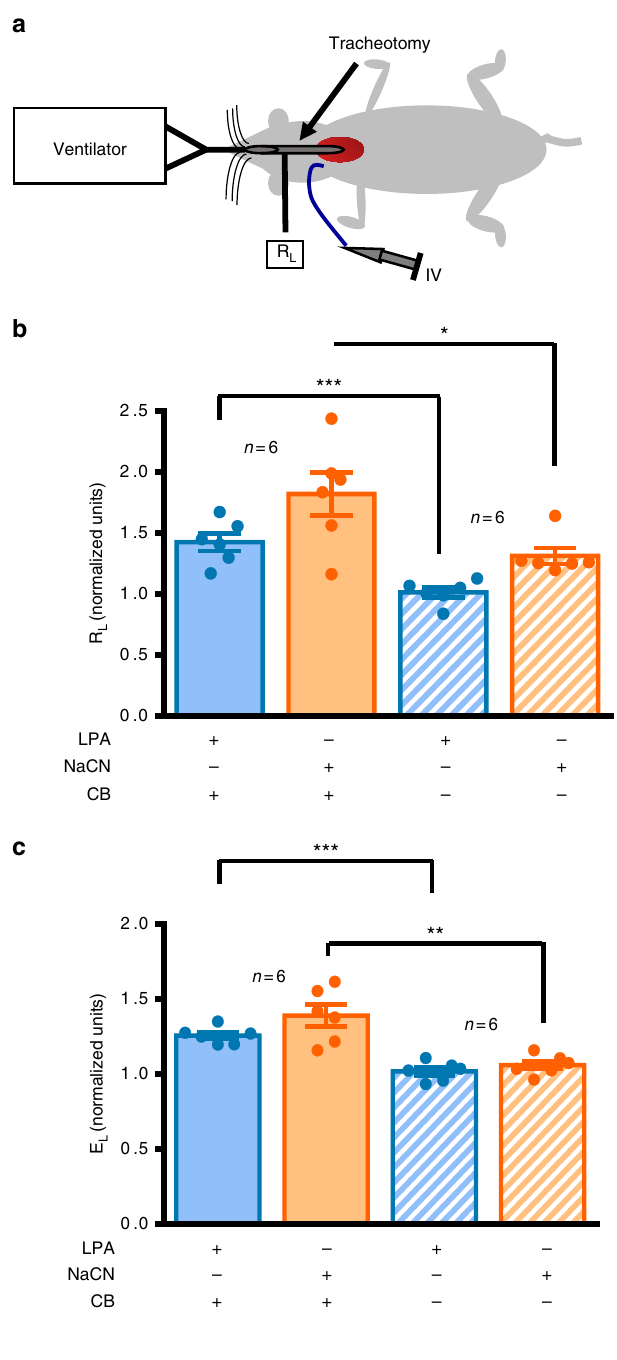
Fig. 3 In vivo carotid body-mediated bronchoconstriction. a – c The anesthetized in vivo preparation used to measure airway mechanics in carotid sinus nerve intact (solid, n = 6) or denervated (crossed, n = 6) preparations, in response to jugular vein injection of lysophosphatidic acid (LPA 5 µ M, blue) or sodium cyanide (NaCN, orange; an independent test